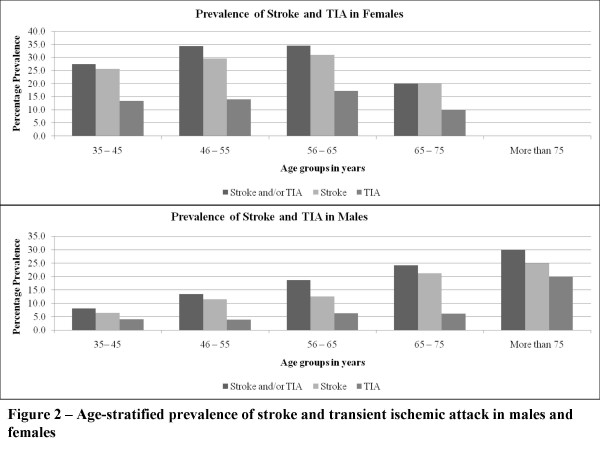
Age-stratified prevalence of cerebrovascular disease in males and females: the life-time prevalence of CVD in females was similar in all age groups (p = 0.611) while that in males rose with old age (p = 0.025). *TIA = Transient Ischemic Attack.